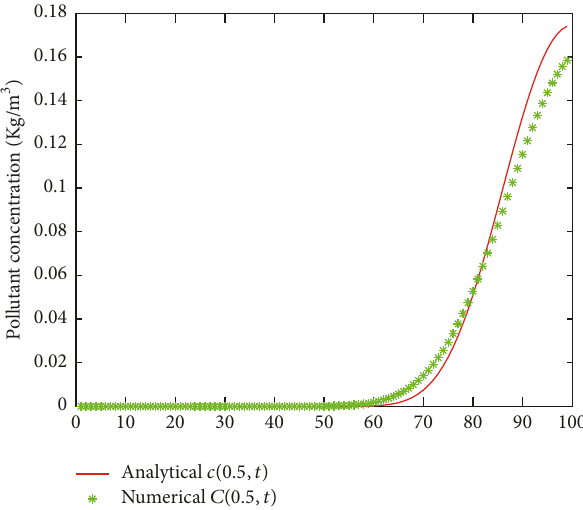
0 100908070605040302010 Analytical c(0.5,t) Numerical C(0.5,t) Figure 3: Comparison of analytical and approximated pollutant concentrations 𝑐(0.5, 𝑡) (kg/m 3 ) (Δ𝑥 = 0.0500 , Δ𝑡 = 0.0100 , Pe = 5.0)